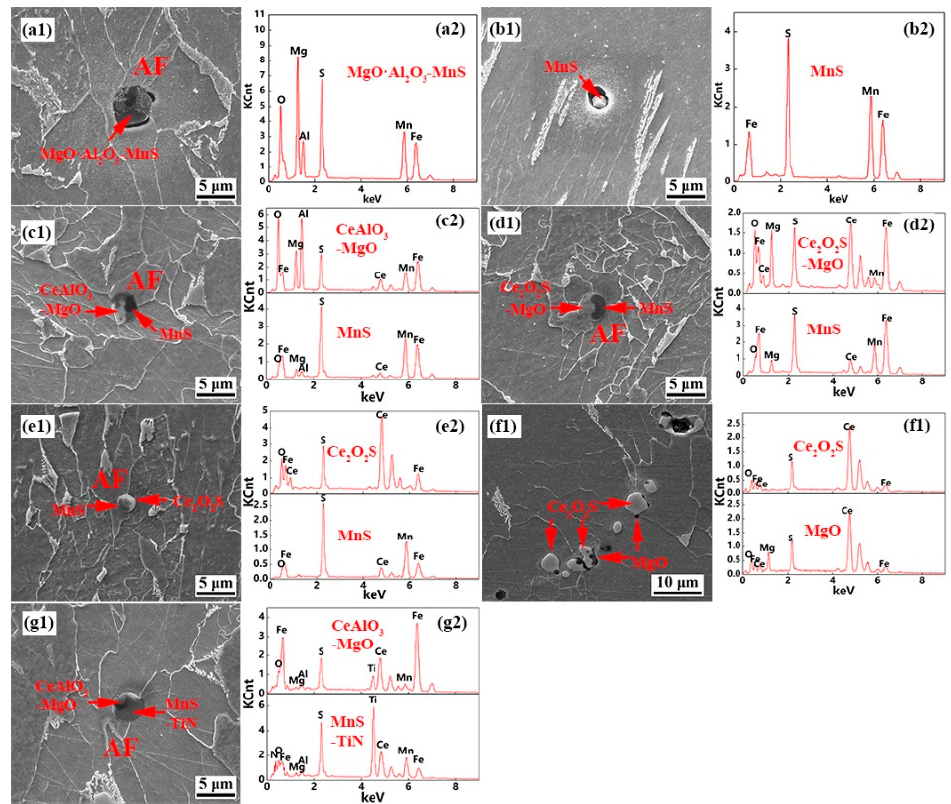
Figure 10. Morphology of acicular ferrite (AF) induced by main types of inclusions in the steel. ( a1 , a2 , b1 , b2 ) #1 (Ce-free); ( c1 , c2 ) #2 (0.014% Ce); ( d1 , d2 ) #3(0.024% Ce); ( e1 , e2 , f1 , f2 ) #4 (0.037% Ce) and ( g1 , g2 ) TiN-containing inclusion in Steel #2.